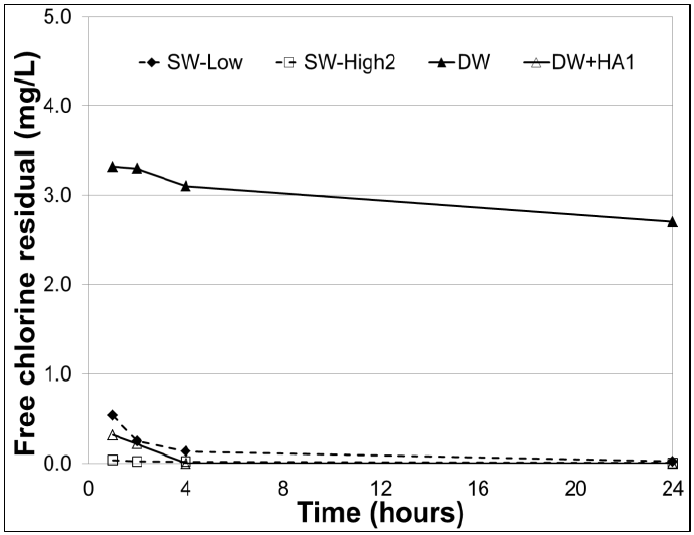
Figure 2. Simulated 24 h storage tests free chlorine residual trends.